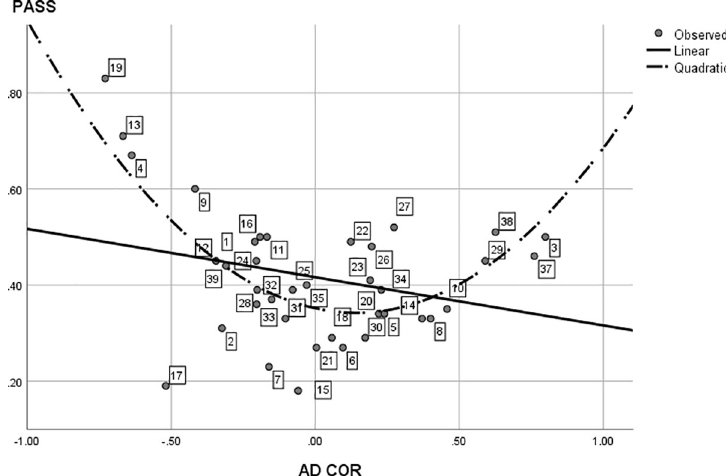
Fig 6. The (curvi-) linear regression of average study program results (PASS) on study program interest diversity. Interest Diversity is measured using AD COR (based on D COR z–scores), with PASS = average pass rate for each study program. The linear regression is depicted as a full line, the quadratic regression is depicted as an interrupted line. The data points (dotted study programs) are labeled analogous to Table 1.With a pass rate of 0%, Geology (36) was considered an outlier and was removed from